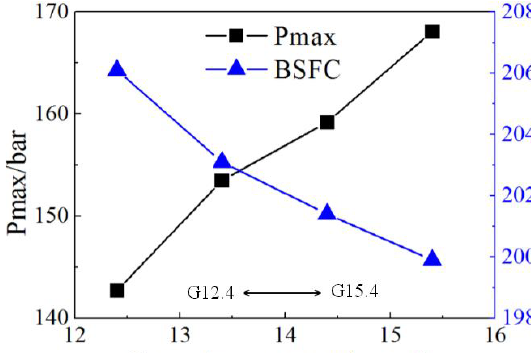
Figure 14. Influence of high ε Miller cycle on maximum cylinder pressure and